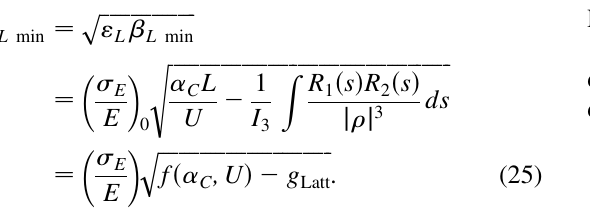
FIG. 9. (Color) Longitudinal emittance (a) and energy spread (b) for the reference ring at two different value of V (cid:6) 3 MV , triangles to V (cid:6) 7 : 5 MV . R (cid:3) s (cid:4) is nonmonotonic for the first four points, monotonic for the two last V rf rf 1